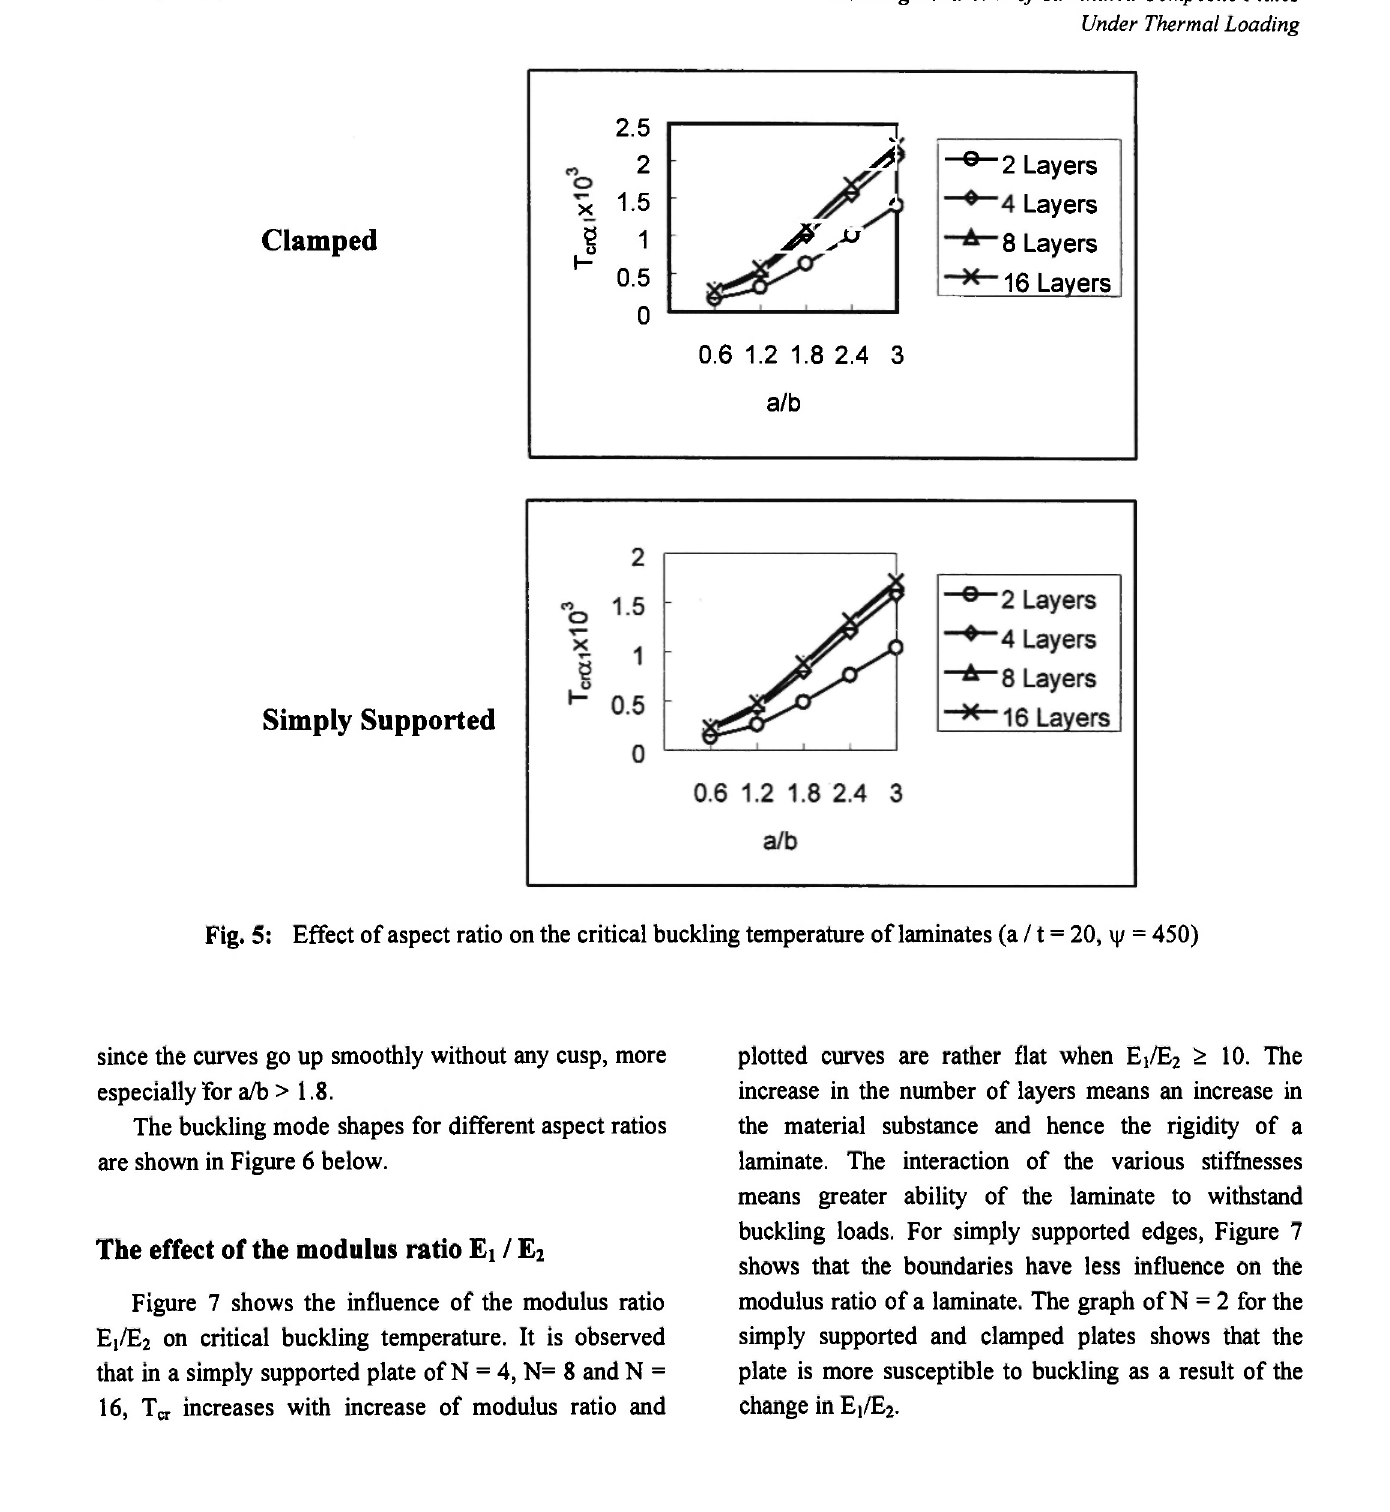
since the curves go up smoothly without any cusp, more especially for dJb >